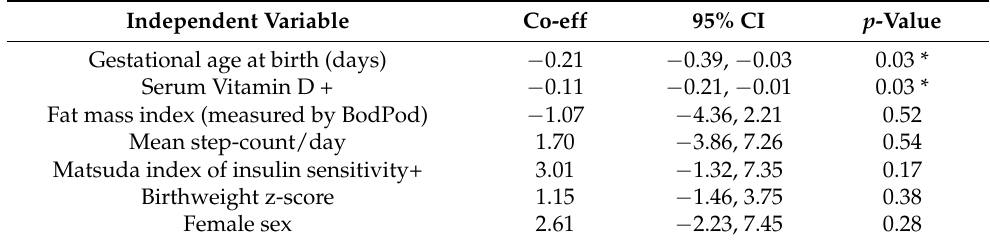
Table 4. Univariable regression analysis for adjusted PCr recovery ( τ 1 / values for the variables that were considered for inclusion in the multivariable model. FMI: fat mass index, * indicate variables that were included in final model, + indicates log